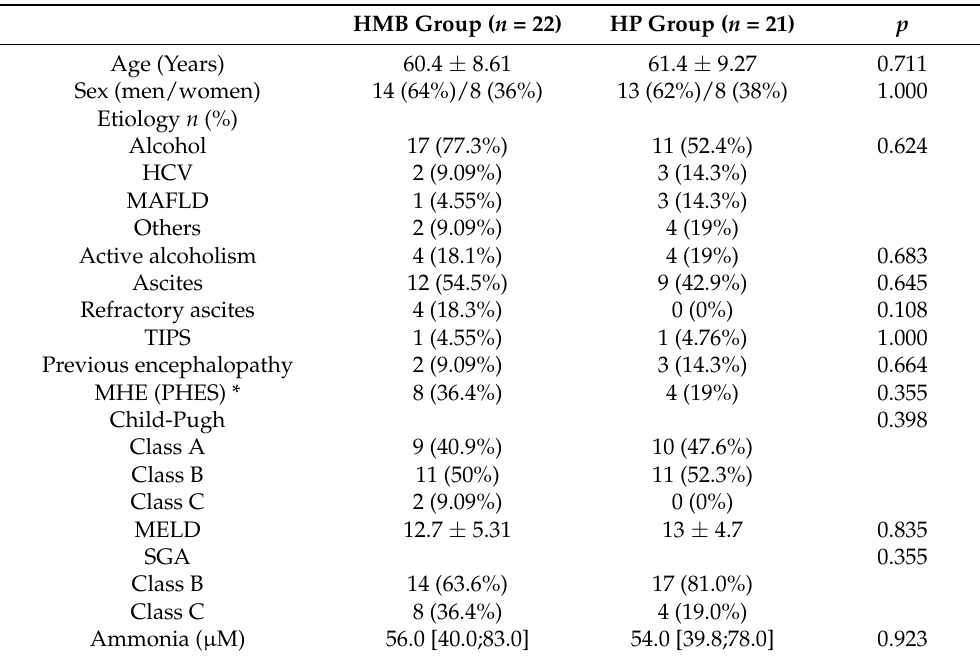
Table 2. Demographics and baseline